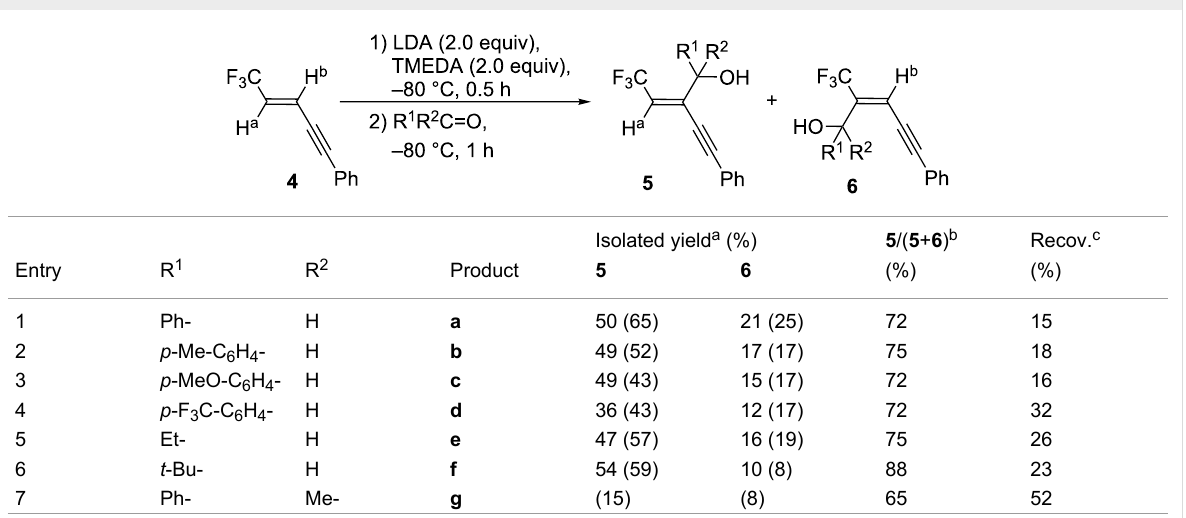
Table 2: Scope and limitation of the present